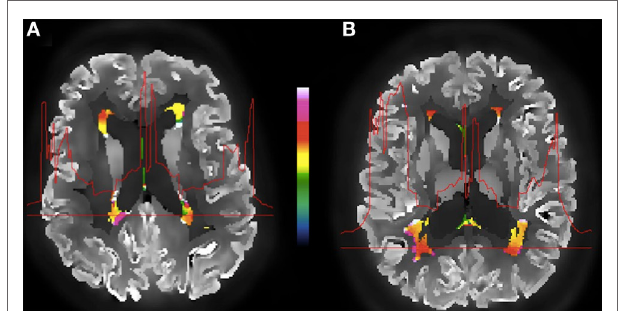
FigUre 3 | example of an amyloid-positive (a) vs. amyloid-negative (B) subject and the corrected FDg-PeT images, WMh segmentation (color), and the metabolic profile (red line) for the selected WMh section across the brain . The color bar indicates normalized relative uptake.